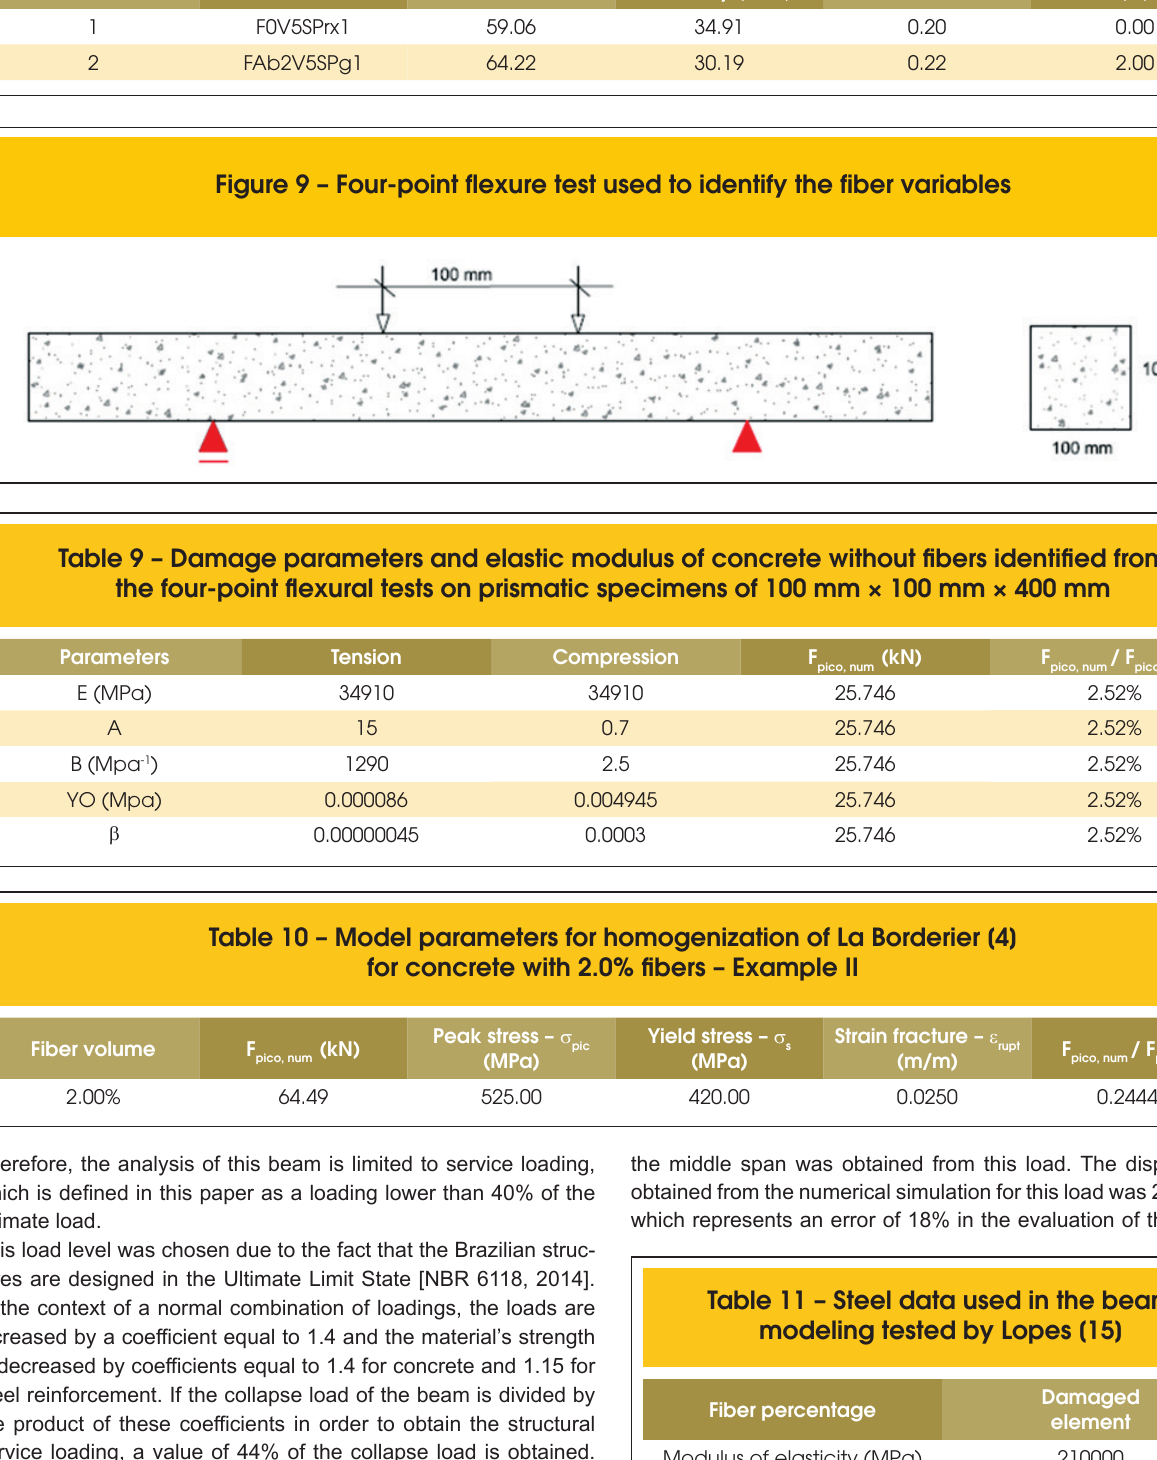
Table 8 – Mechanical properties of concrete obtained by Lopes [15] and used in numerical modeling Concrete